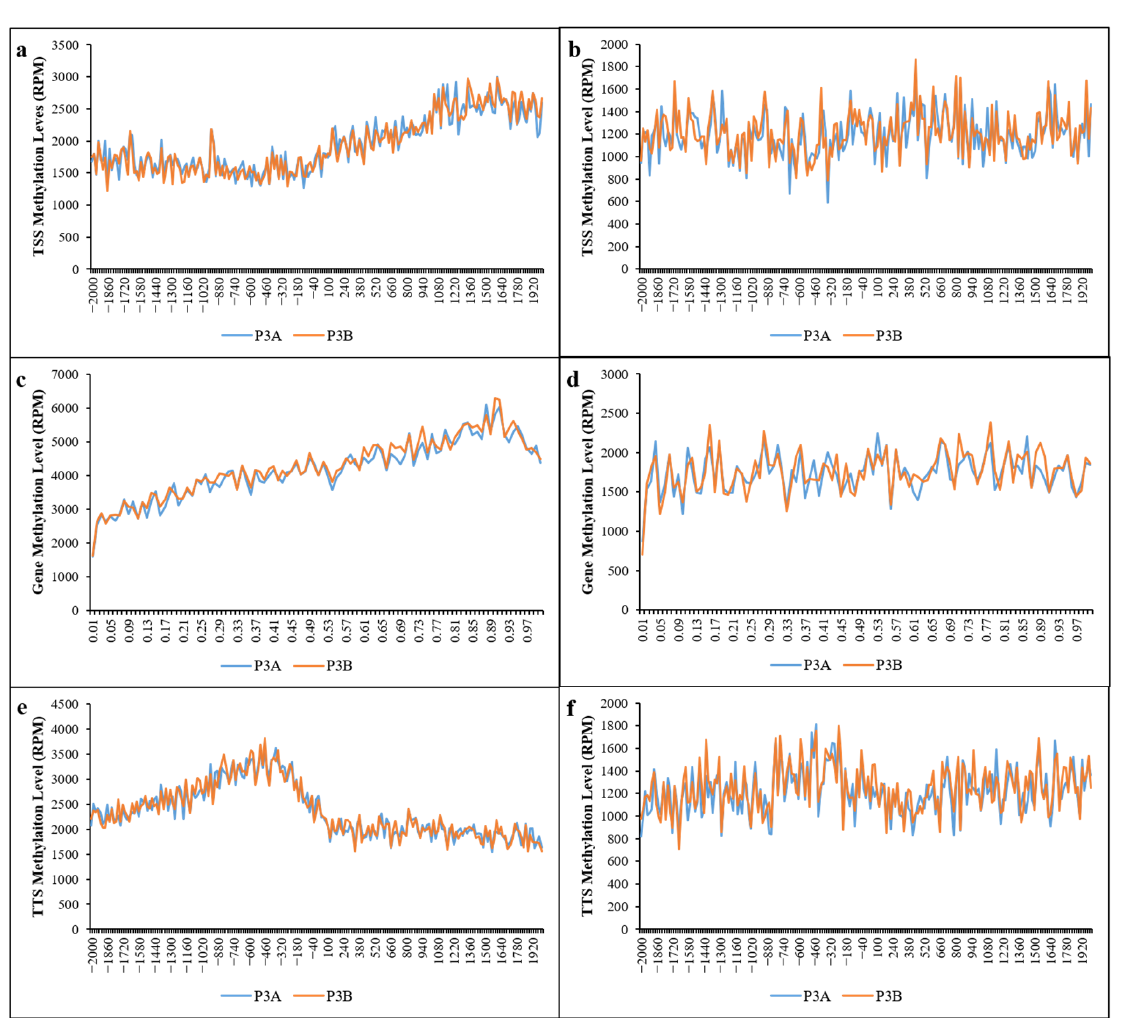
Figure 3. Distribution of methylation sites in the gene body. ( a , b ) Distribution of CCGG and CCWGG methylation sites 2 kb upstream and downstream of the transcription start site (TSS) region, respec- tively; ( c , d ) distribution of CCGG and CCWGG methylation sites in the gene-coding region, respec- tively; ( e , f ) distribution of CCGG and CCWGG methylation sites 2 kb upstream and downstream of